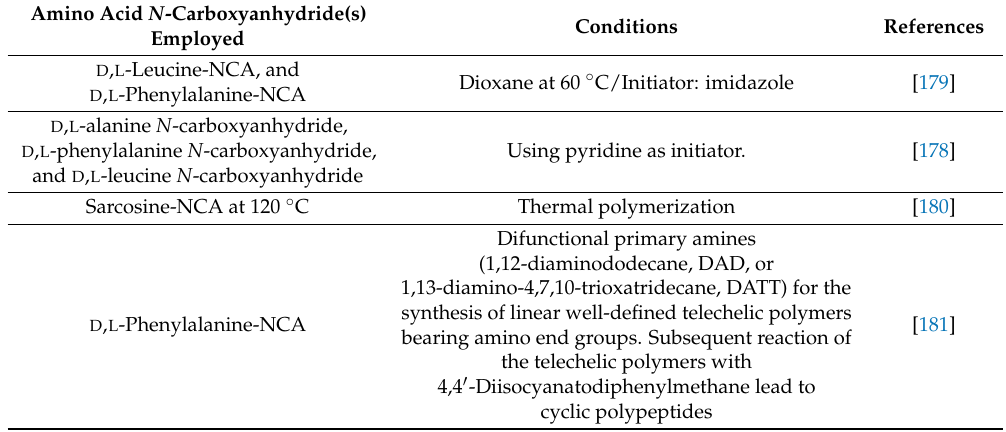
Table 5. Summary of strategies and aminoacids employed to fabricate cyclic polypeptides.